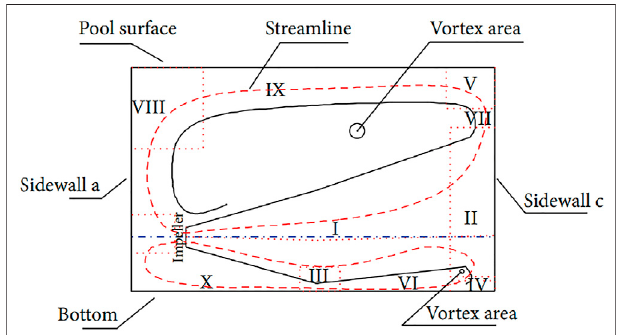
FIGURE 4 | Flow diagram in pool. (I) Free jet region; (II) the region impactingwithsidewallc;(III) theregionimpactingwiththebottomofthepool; (IV) the region impacting with the bottom of the pool; (V) the region impacting with the surface of the pool; (VI) the region of the bottom of the pool wall jet; (VIII) the region of radial wall jetting with the sidewall c; (IX) the region of radial wall jetting with the pool surface.